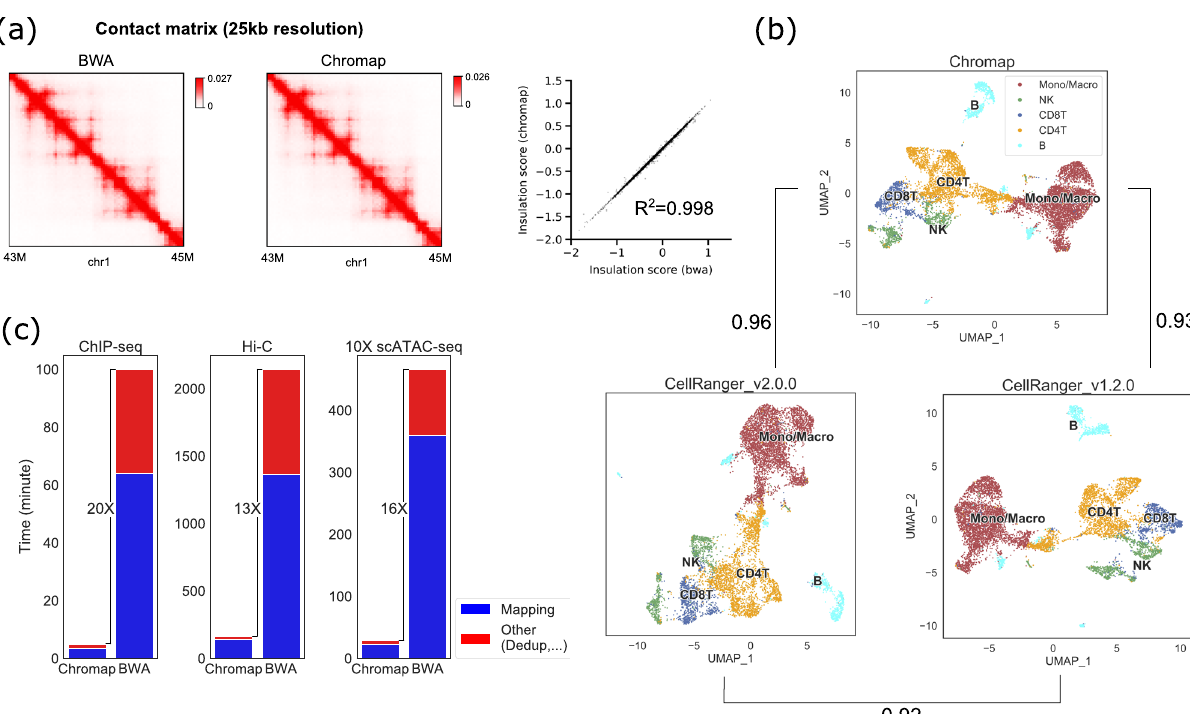
Fig. 2 Chromap on the large data set. a Comparison of Hi-C contact matrices at 25 kb resolution and insulation scores for TADs analysis derived from Chromap and BWA-MEM alignments. b Cluster annotation and NMI of the PBMC 10x Genomics scATAC-seq data based on the results of Chromap and CellRanger. c Running time of Chromap and work fl ows based on BWA-MEM on ChIP-seq, Hi-C, and 10x Genomics scATAC-seq